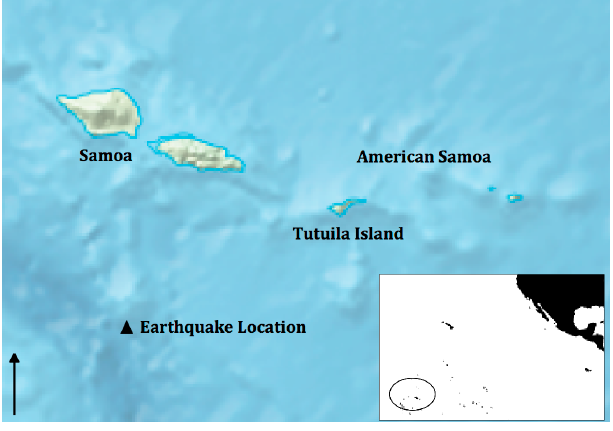
Fig. 1 . American Samoa and the larger